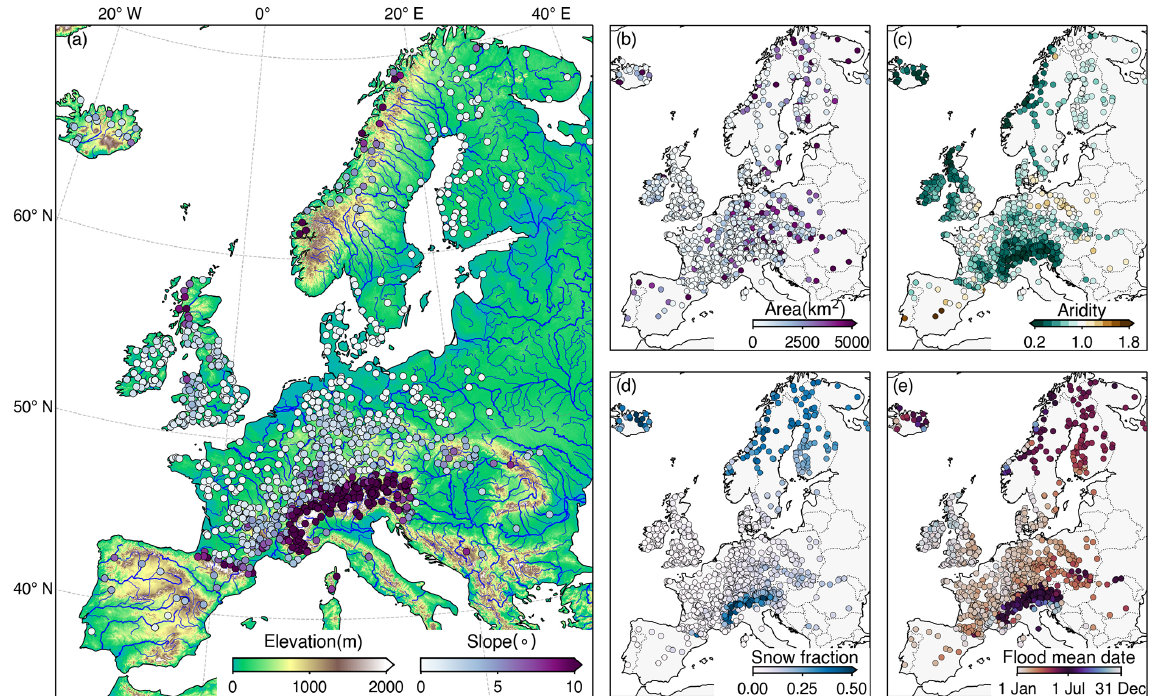
Figure 1. An overview of the 1077 catchments and their properties, including (a) average elevation and slope of the catchments; (b) the catchment size; (c) the aridity index, expressed by the ratio between mean annual potential evapotranspiration (PET) over mean annual precipitation; (d) the fraction of precipitation falling as snowfall (i.e., precipitation falling with a temperature below 0 ◦ C); and (e) the seasonality of annual maximum discharges. PET was estimated via Hamon’s formulation (Hamon,